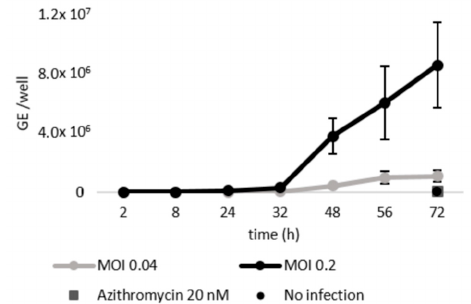
Figure A1. Growth kinetics of C. pneumoniae in HL epithelial cell. Cells were infected at MOI 0.04 or 0.2 IFU / cell and C. pneumoniae genome copy numbers were determined with qPCR on ompA gene in seven time points. Data are presented as number of genome equivalents per well and shown as mean ± SEM (n =